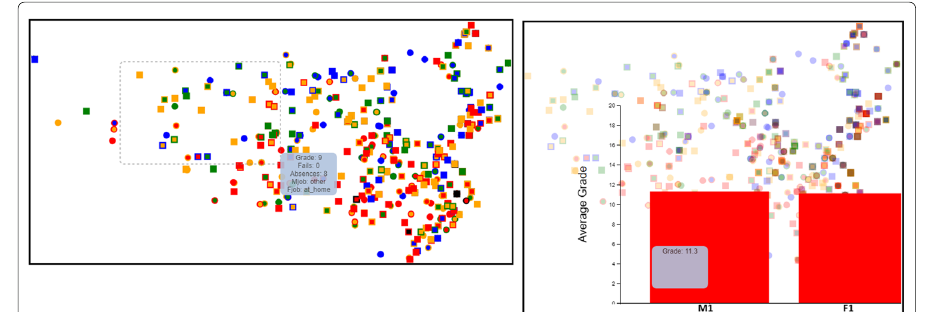
Fig. 9 Isomap visualization of "Portuguese" course. Different levels of education are color coded. Female students are rectangles and male students circles. Mother’ education is represented by glyphs colors and father’ education is represented by glyphs strokes. A selection on Isomap shows the correspondent average of grades for male and female